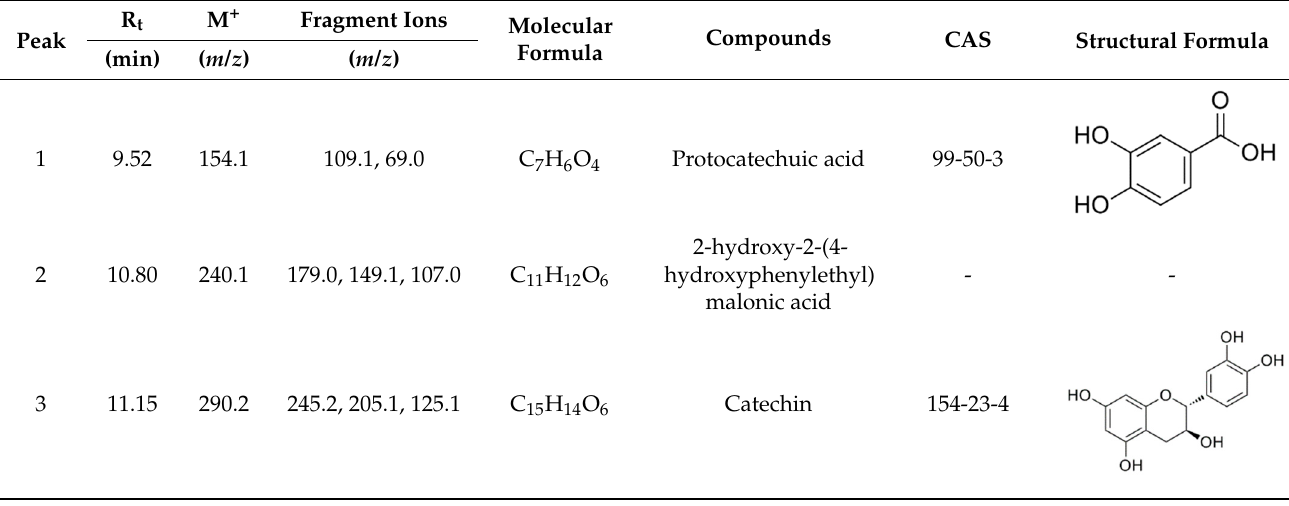
Table 1. The identification of phenolic compounds from the ethanolic extract of the Torreya grandis seed coat by UPLC-QTOF-MS.